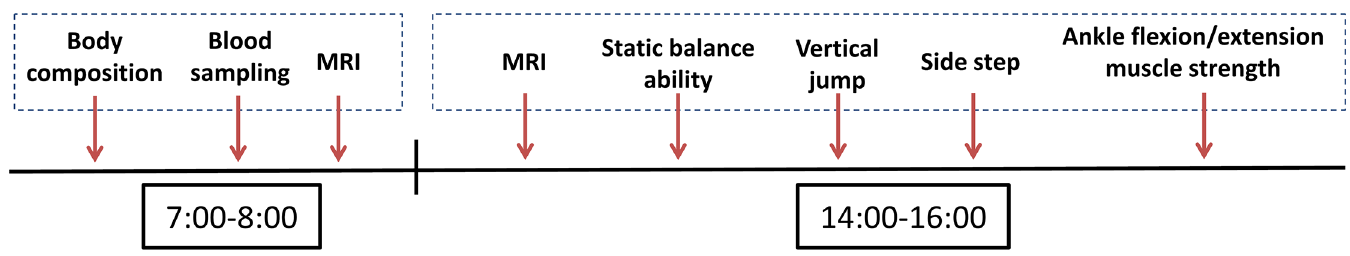
Fig 1. Flow of the measurements in each phase of the